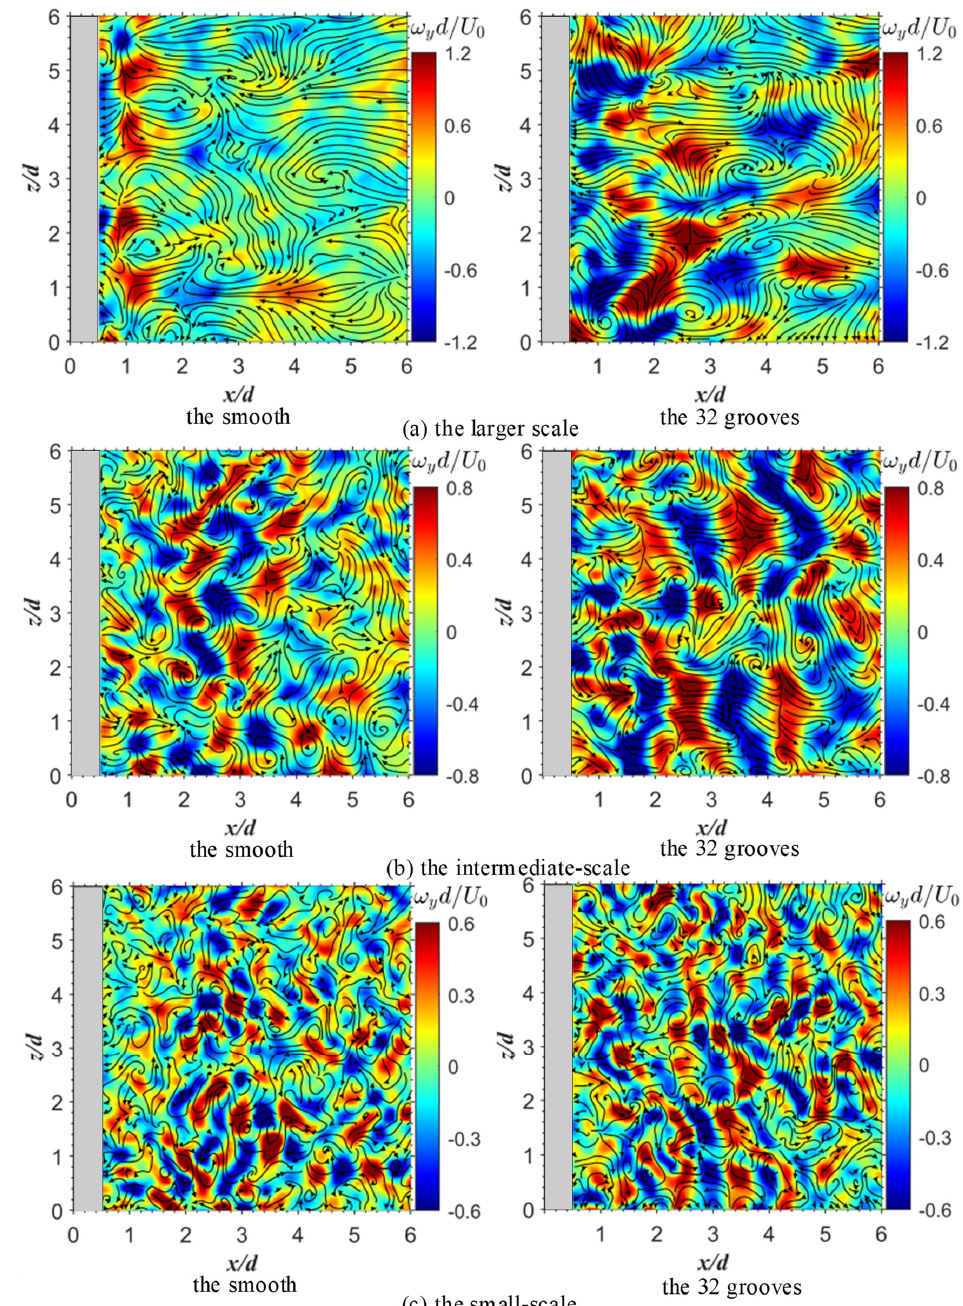
Figure 16. Multi-scale instantaneous streamlines and vorticity contours of the smooth and 32-groove cylinders in the ( x, z )-plane.